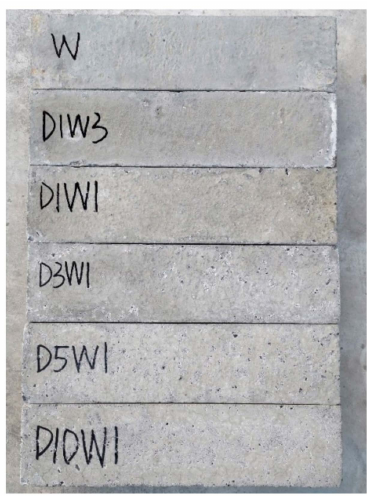
Figure 3. Visual inspection of concrete exposed to sulfate solution under drying–wetting cycles.